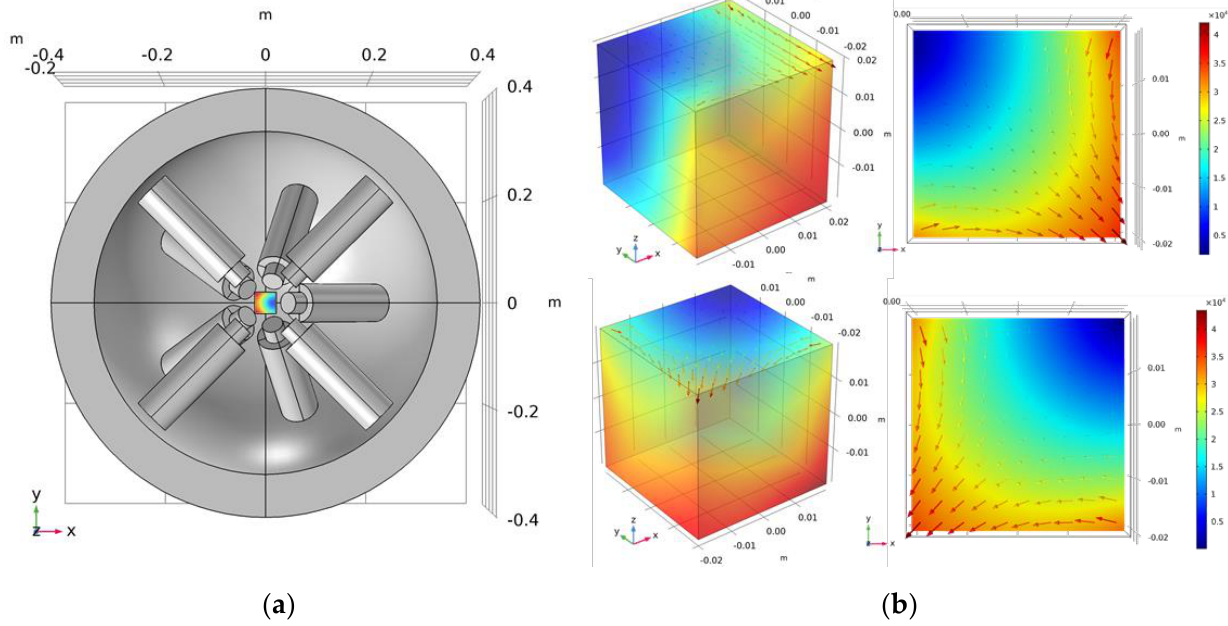
Figure 5. ( a ) Simulation model of proposed nine-coil EMA system; ( b ) simulated FFP obtained from COMSOL at predetermined positions.